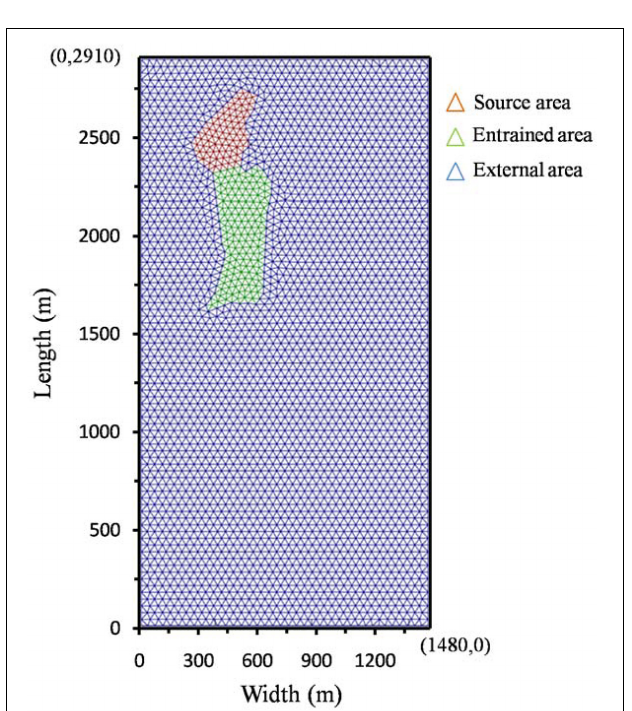
FIGURE 7 | Two-dimensional model of the Xinmo Landslide with three sub areas.